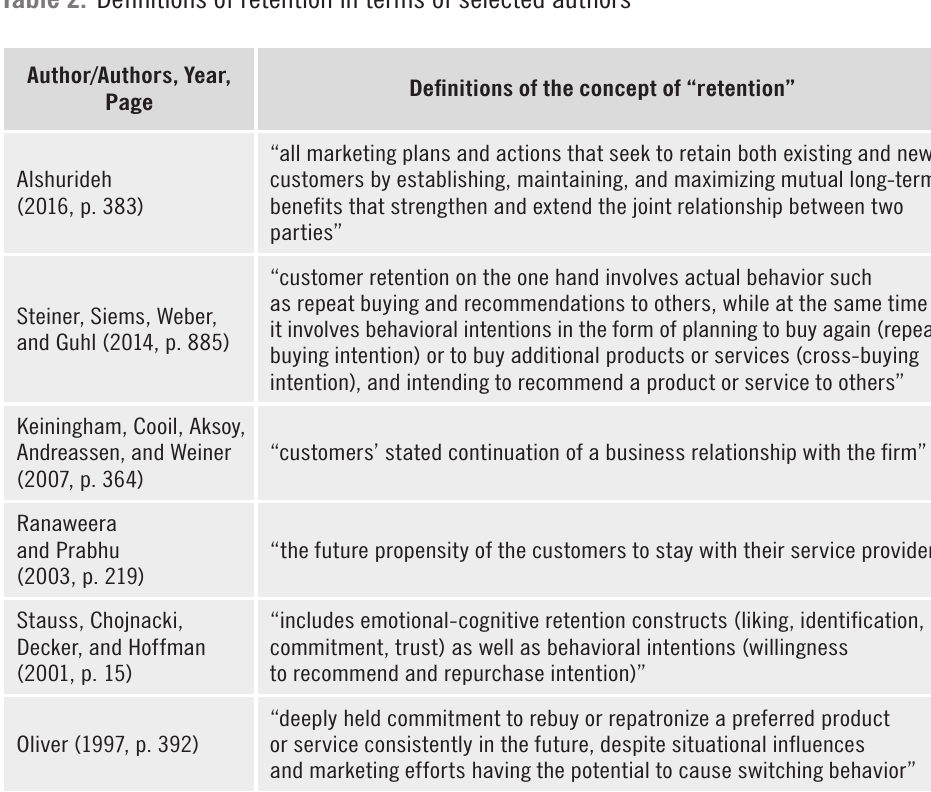
Table 2. Definitions of retention in terms of selected